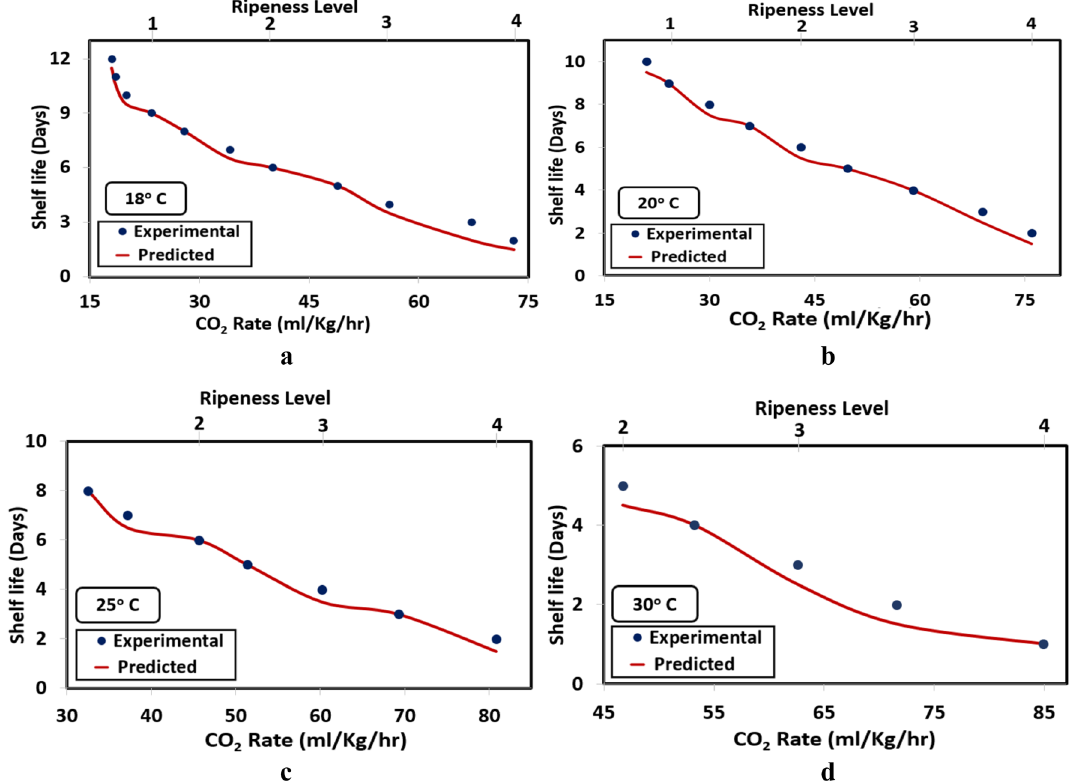
Fig. 7 Shelf life prediction of ‘Kesar’ cultivar of mangoes at a 18 °C, b 20 °C, c 25 °C, d 30